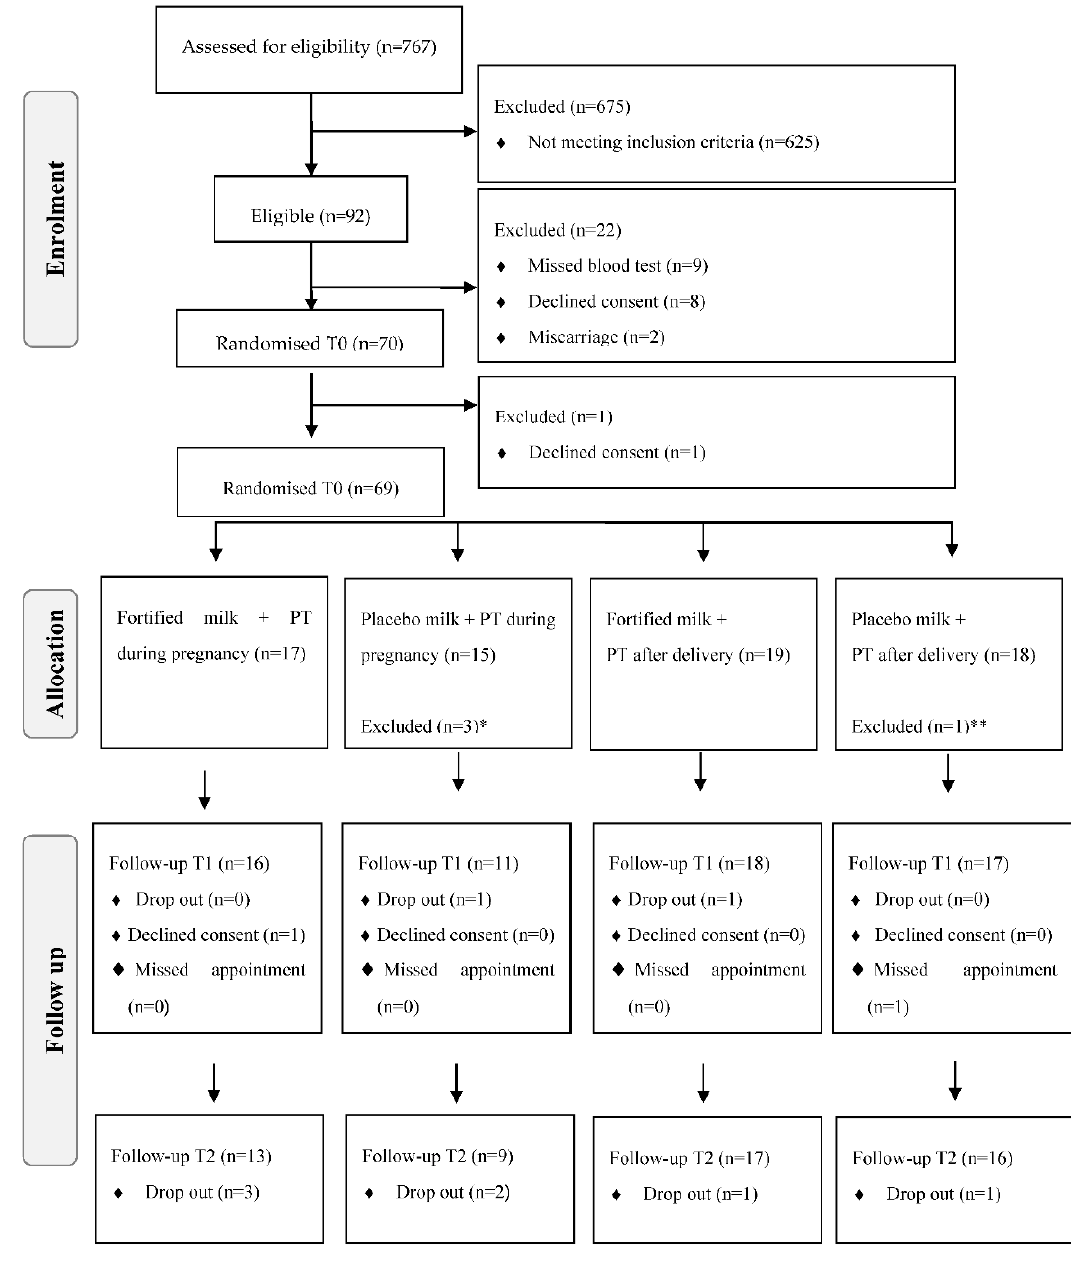
Figure 1. Flowchart of enrolment, allocation, and follow up of the pregnant women from a low socioeconomic area in Rio de Janeiro. PT: Periodontal therapy. * Not started periodontal treatment (n = 1) or milk consumption (n = 1) or both (n = 1). ** Not started milk consumption (n = 1).